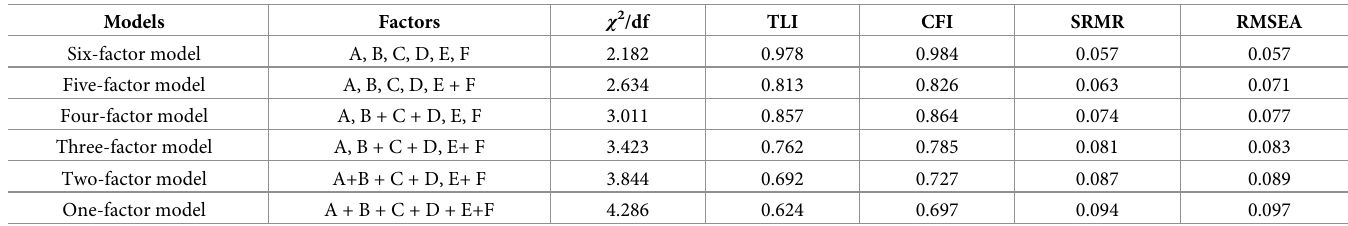
Table 1. Confirmatory factor analysis results.